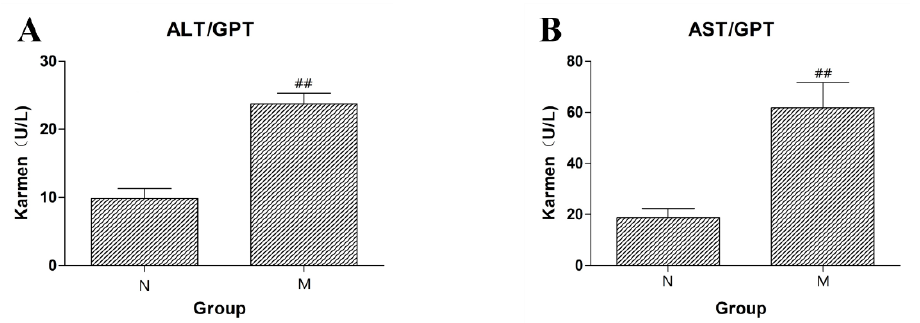
Figure 2. ( A ) The content of ALT in rat serum of the normal control (N) group and the liver injury model (M) group. ( B ) The content of AST in rat serum of the normal control (N) group and the liver injury model (M) group ( ## p < 0.01 compared to N).